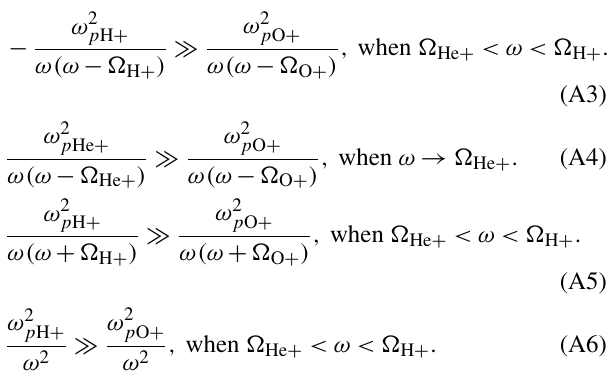
Figure A1. Dispersion relations around ion gyrofrequencies for per- pendicular wave mode, under the conditions of B 0 = 1180nT and n e = 1500cm − 3 . (a) The plasma contains no O + ions. (b) The plasma contains 5% O + ions. For each case, the ratio of He + cut- off frequency to H + gyrofrequency f cutHe + / f c H + is set to 0.261 (based on the event), and the abundance ratios of H + and He + are obtained accordingly. One can find that the difference in the MS mode dispersion curve (red curve) is small for the two sets of ion abundance